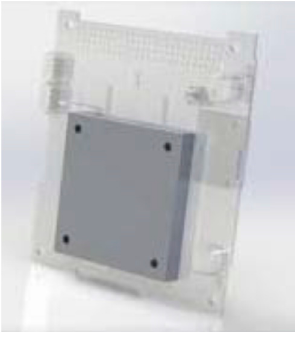
Figure 28. 2100 J CubeSat Thermal Storage Unit [46].